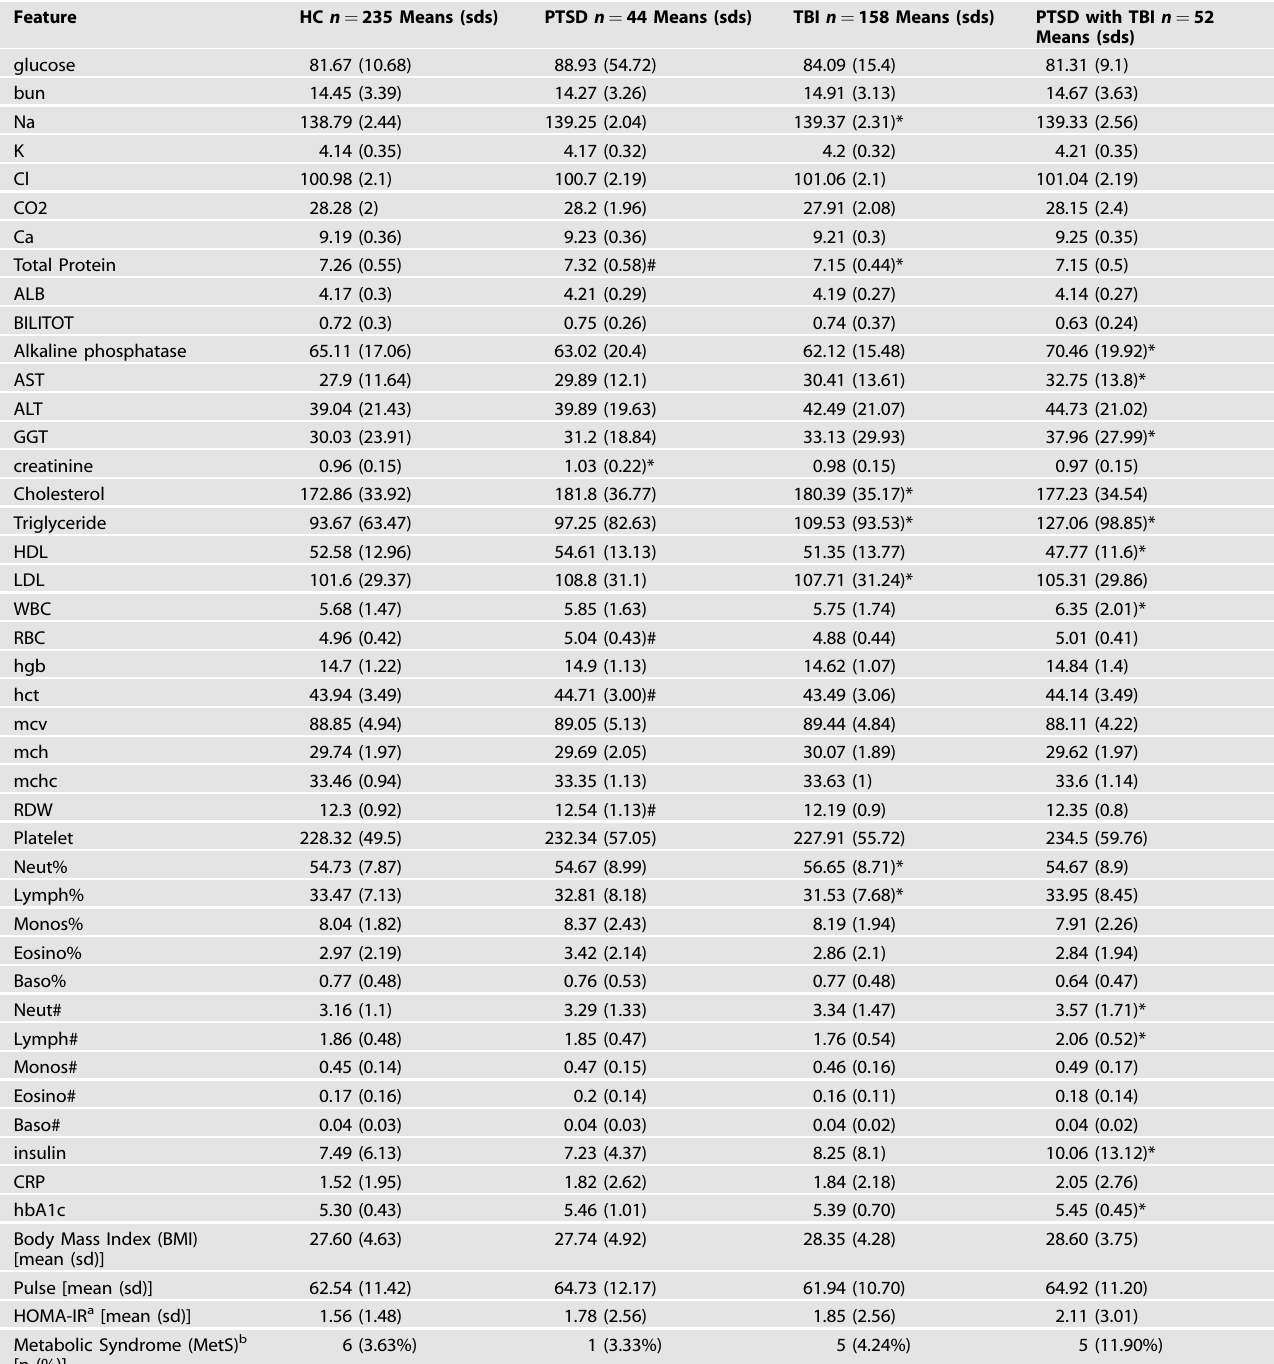
Table 1. Feature value comparisons for study